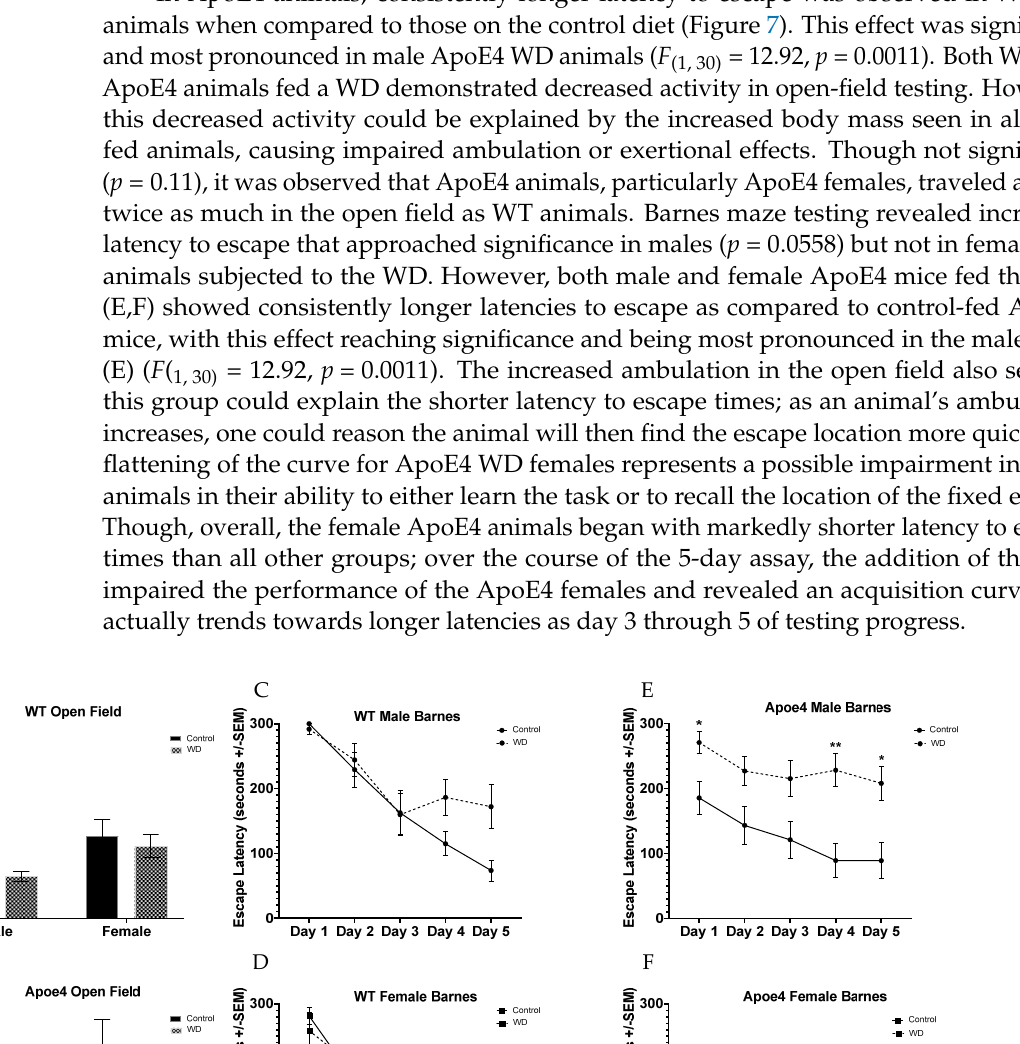
Commented [M32]: please replace hyphen as minus sign in figure. Figure 7 is not behind of first citation. Please consider this location change.